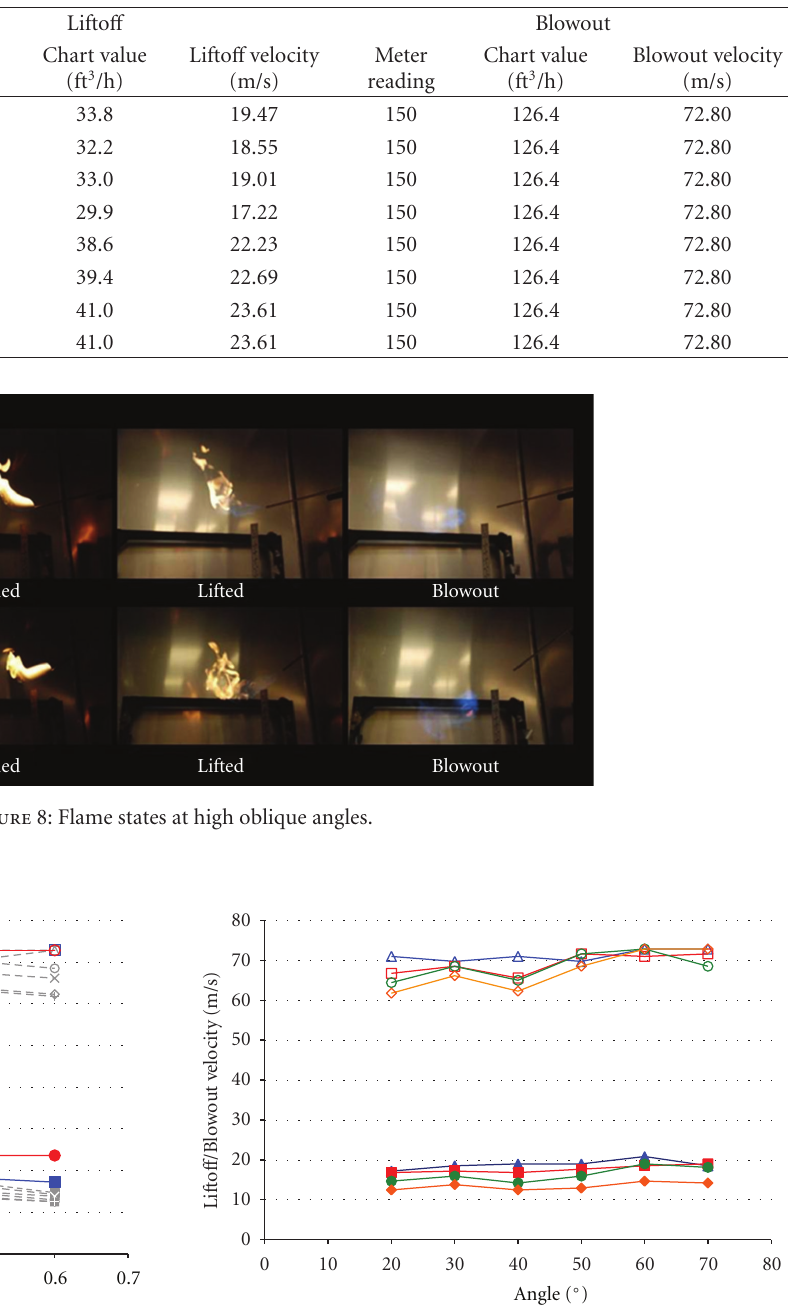
Table 2: Lifto ff and blowout velocities for 90 ◦ and 110 ◦ flow configurations.